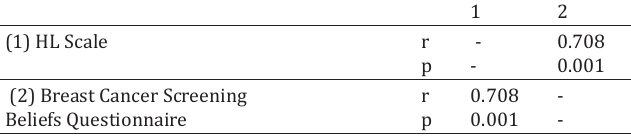
Correlation of Scale Score Means (n=400)